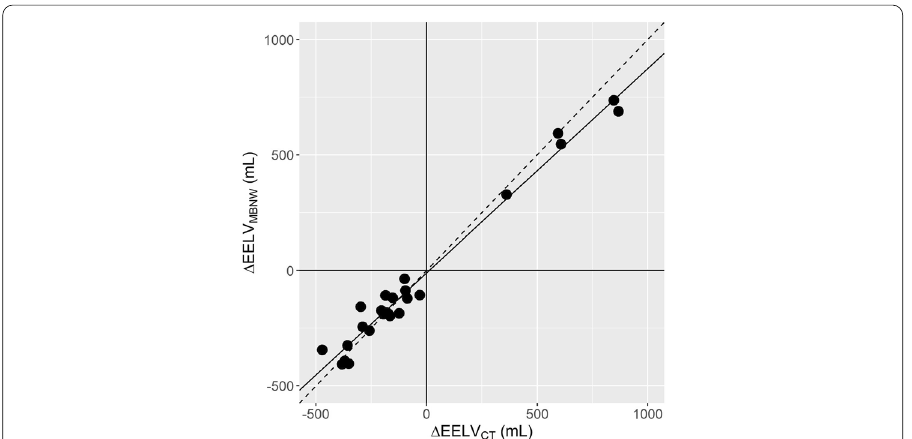
Fig. 3 Four quadrants plot relating EELV MBNW and EELV CT changes between consecutive measurements. Horizontal and vertical continuous black lines are quadrant limits. Oblique dashed line is line of identity. Solid line is regression line. Each symbol is the change in end‑expiratory lung volume between consecutive measurements assessed with the multiple breath nitrogen washin–washout technique (ΔEELV MBNW ) and with computed tomography (ΔEELV CT